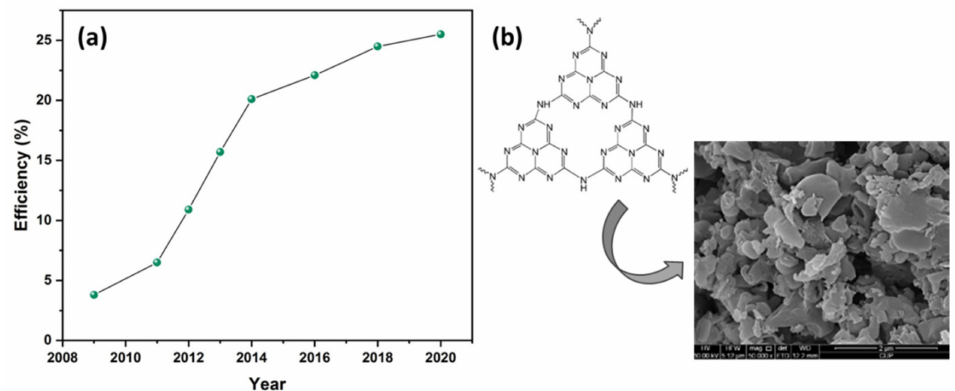
Figure 1. ( a ) Perovskite solar cells’ (PSCs’) certified efficiency evolution 2009–2020 and ( b ) the structure and morphology (SEM image) of graphitic carbon nitride (g-C 3 N 4 ). Reproduced with permission from [27], Copyright 2014,